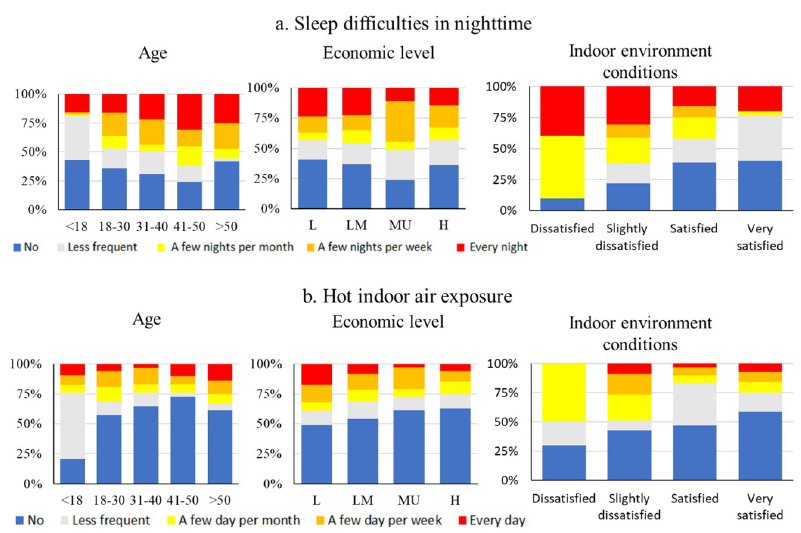
Fig 3. Percentage of respondents who experienced sleep difficulties and hot indoor air exposure according to their age, economical level, and indoor environmental conditions.